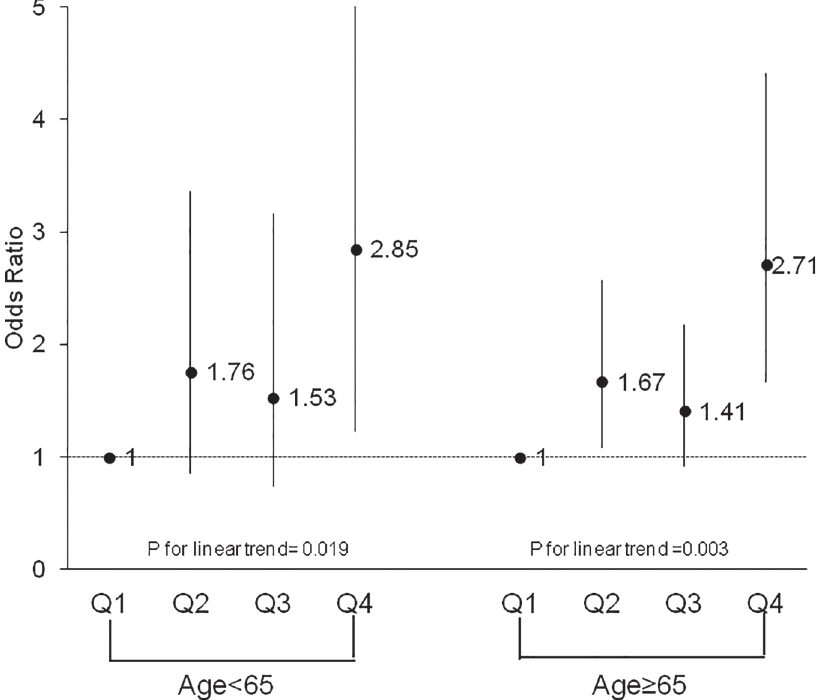
Fig 1. Odds ratios above the norm for health-related quality of life physical component score according to cardiorespiratory fitness quartile and age group among females. Logistic regression adjusting for age, body mass index, smoking status, hypertension, and physical inactivity was used to obtain odds ratios and the p-value for the trend analysis, Q,